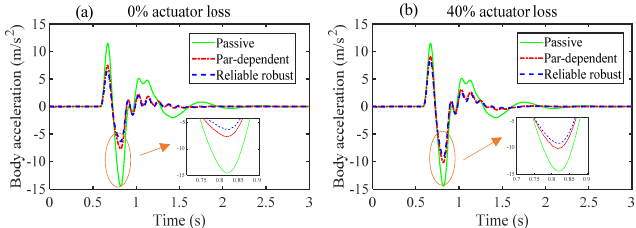
Figure 15. Body acceleration of the vehicle: (a) under 0% actuator loss; (b) under 40% actuator loss.